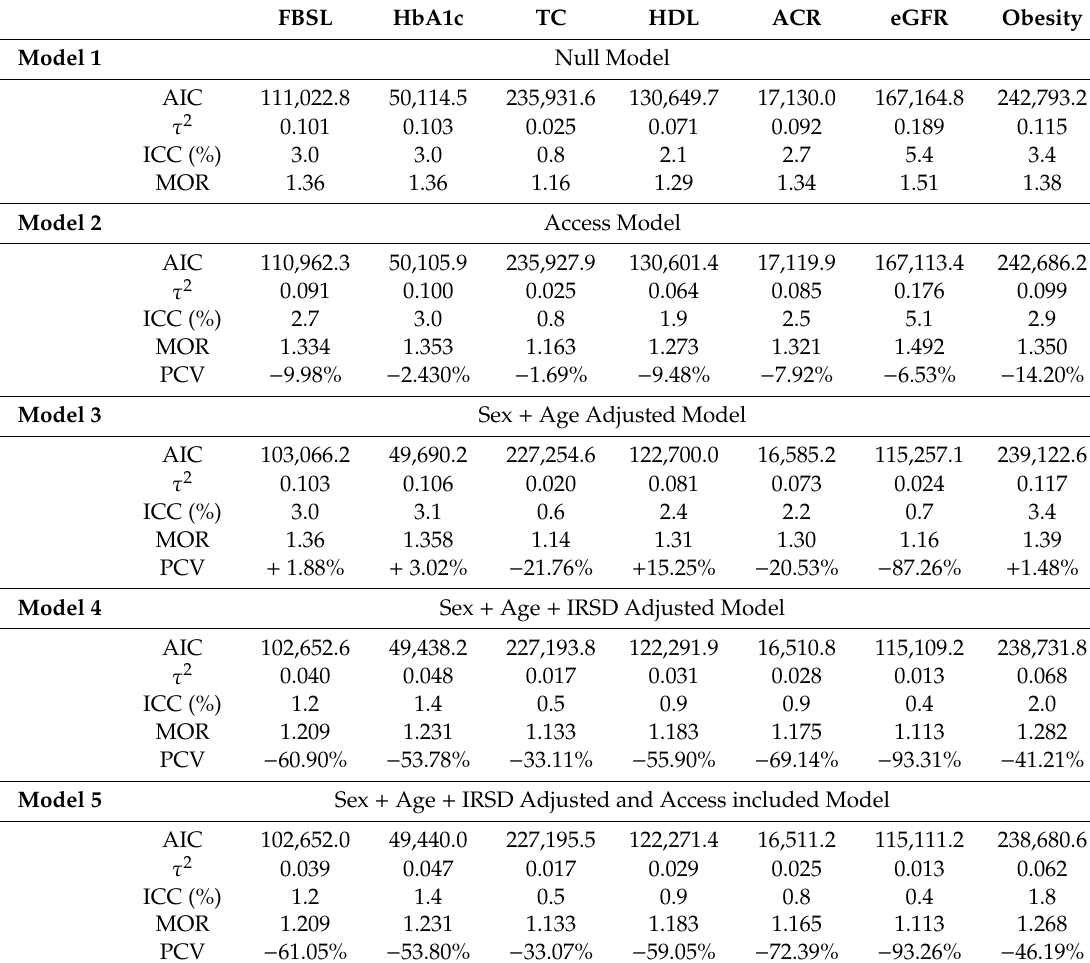
Table 10. Summary of model fit values and comparison of the